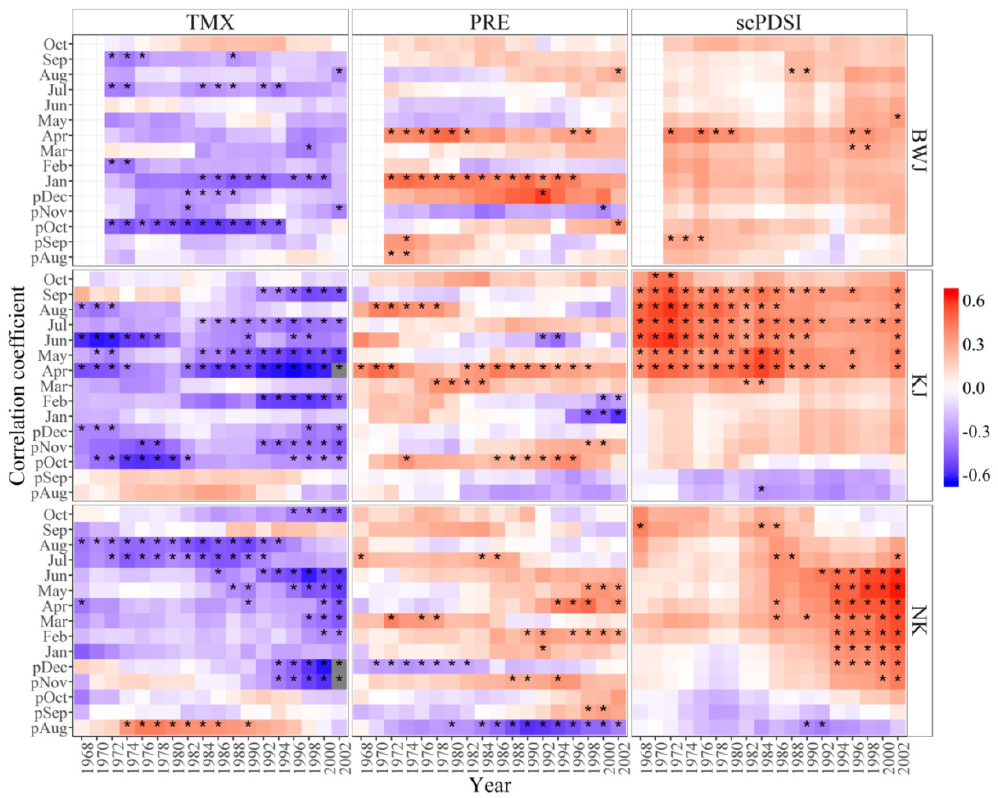
Figure 4. Moving correlations (bootstrapped) between tree-ring residual chronologies and climate data (TMX: maximum temperature, PRE: precipitation, scPDSI: self-calibrated Palmer drought severity index) for the BWJ, KJ and NK sites in Thailand. Correlations were calculated for a 30-year moving window with 2-year overlaps for the period 1951–2017. Scale bars show the ranges of correlation coe ffi cients; asterisks indicate significance at p < 0.05